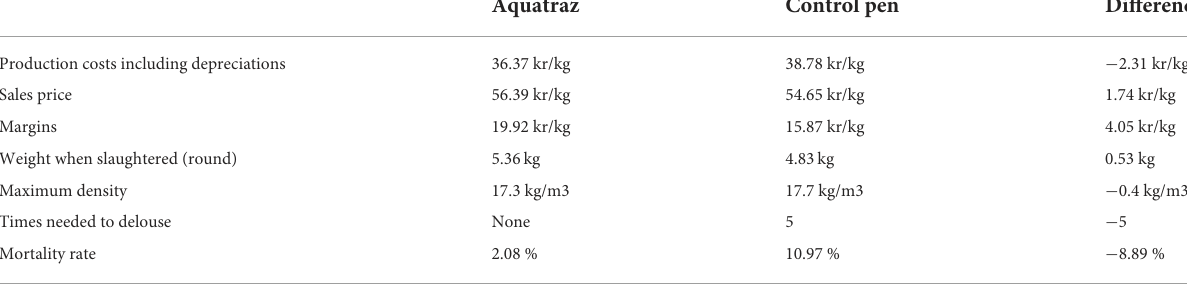
TABLE 1 Difference in various factors related to costs, profits and mortality rates between the Aquatraz demonstration project in Eiterfjorden (2021), Northern Trøndelag, and a control